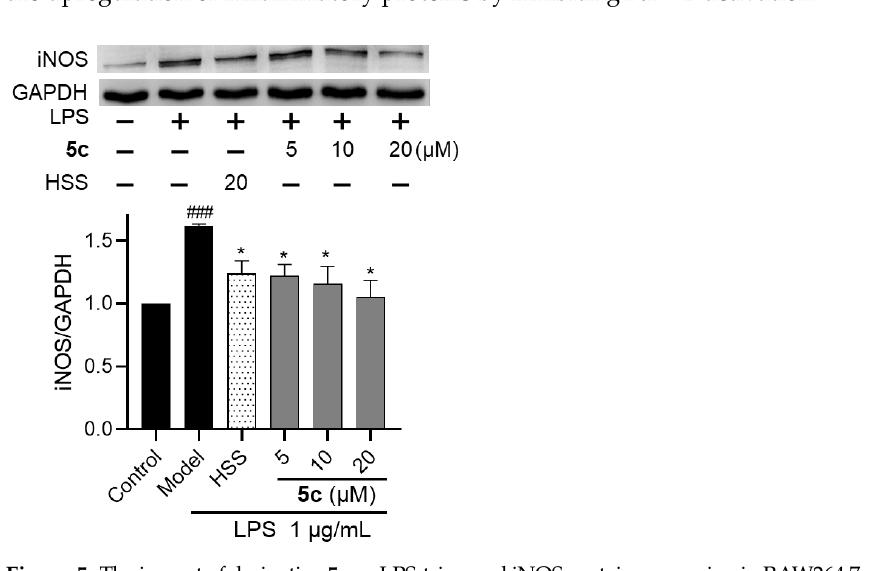
Figure 5. The impact of derivative 5c on LPS-triggered iNOS protein expression in RAW264.7 macrophages following 24-h treatment with a combination of LPS (1 µ g/mL) and 5c or HSS. Data are expressed as means ± SD ( n = 3) from triplicate experiments. ### p < 0.001 vs. control; * p < 0.05 vs. model.